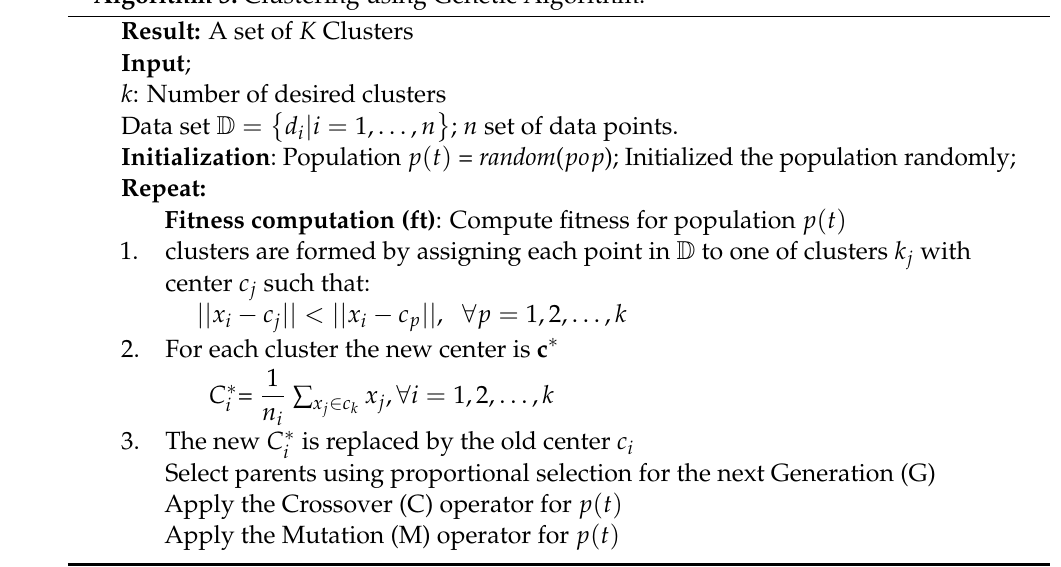
Algorithm 3: Clustering using Genetic